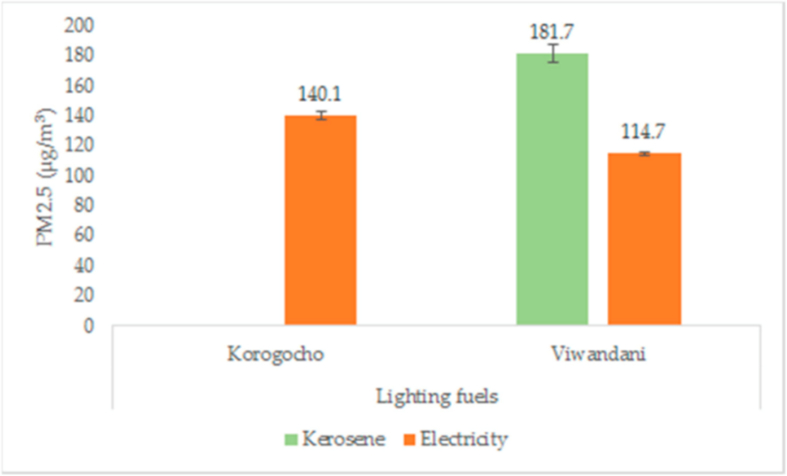
PM2.5 levels associated with lighting fuels.